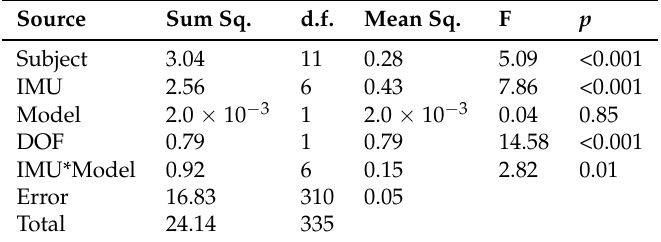
Table 5. ANOVA model of estimated IMU pitch/roll RMSE.